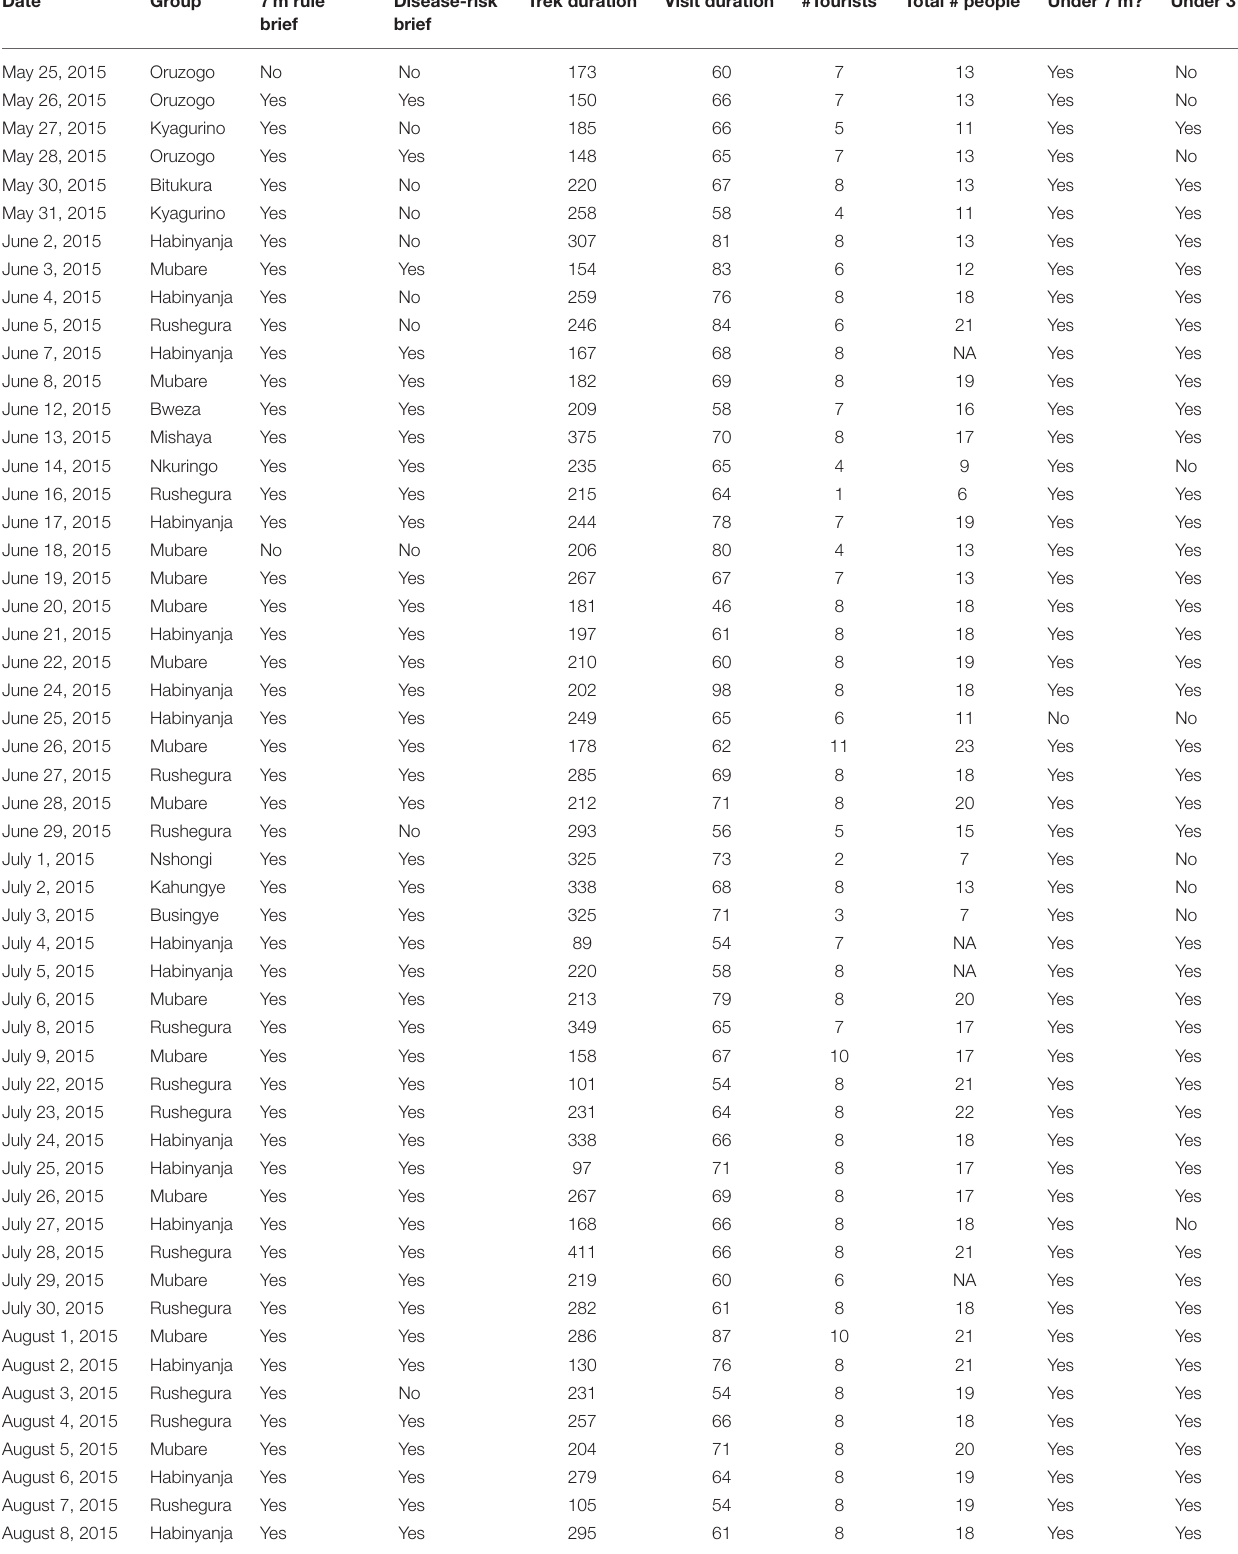
TABLE 1 | Data collected during gorilla tourism encounters in